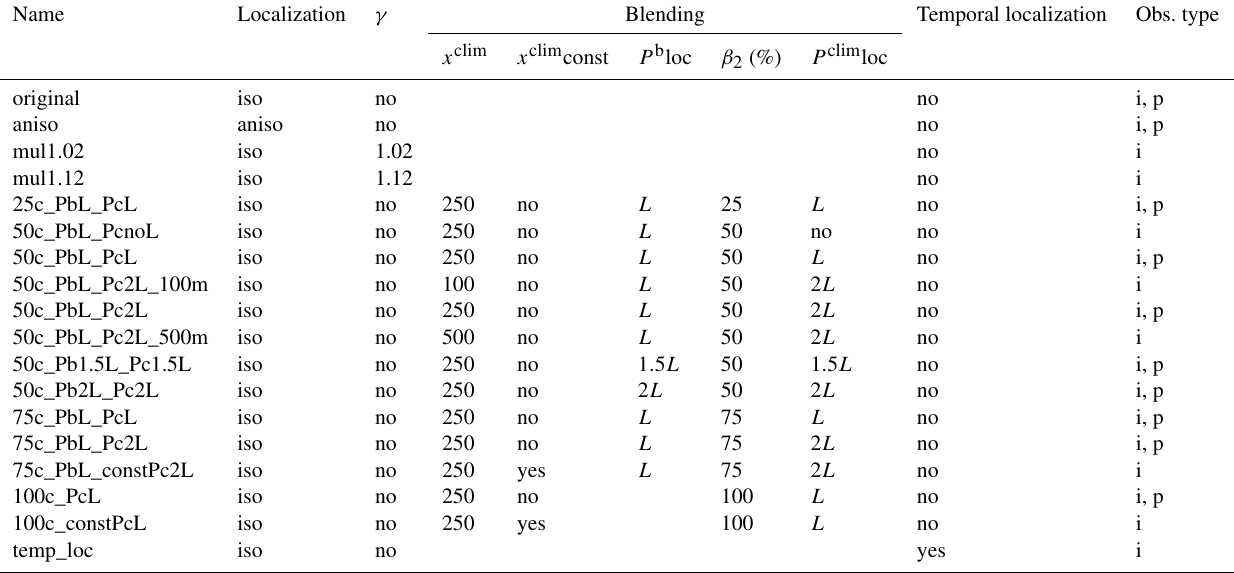
Table 2. Summary of the experiments carried out in this study. The names of the experiments indicate which settings were used in the assimilation. Localization refers to the shape of the localization function applied on P b . γ is the multiplicative inflation factor. x clim indicates from how many ensemble members the climatological state vector was constructed. x clim const stands for keeping the climatological part in the blending experiment unchanged in one October–September time window. P b loc indicates the localization length scale parameter applied for localizing P b . β 2 refers to the weight given to P clim . P clim loc indicates the localization length scale parameter applied for localizing P clim . i and p stand for instrumental-only and proxy-only observation experiments,